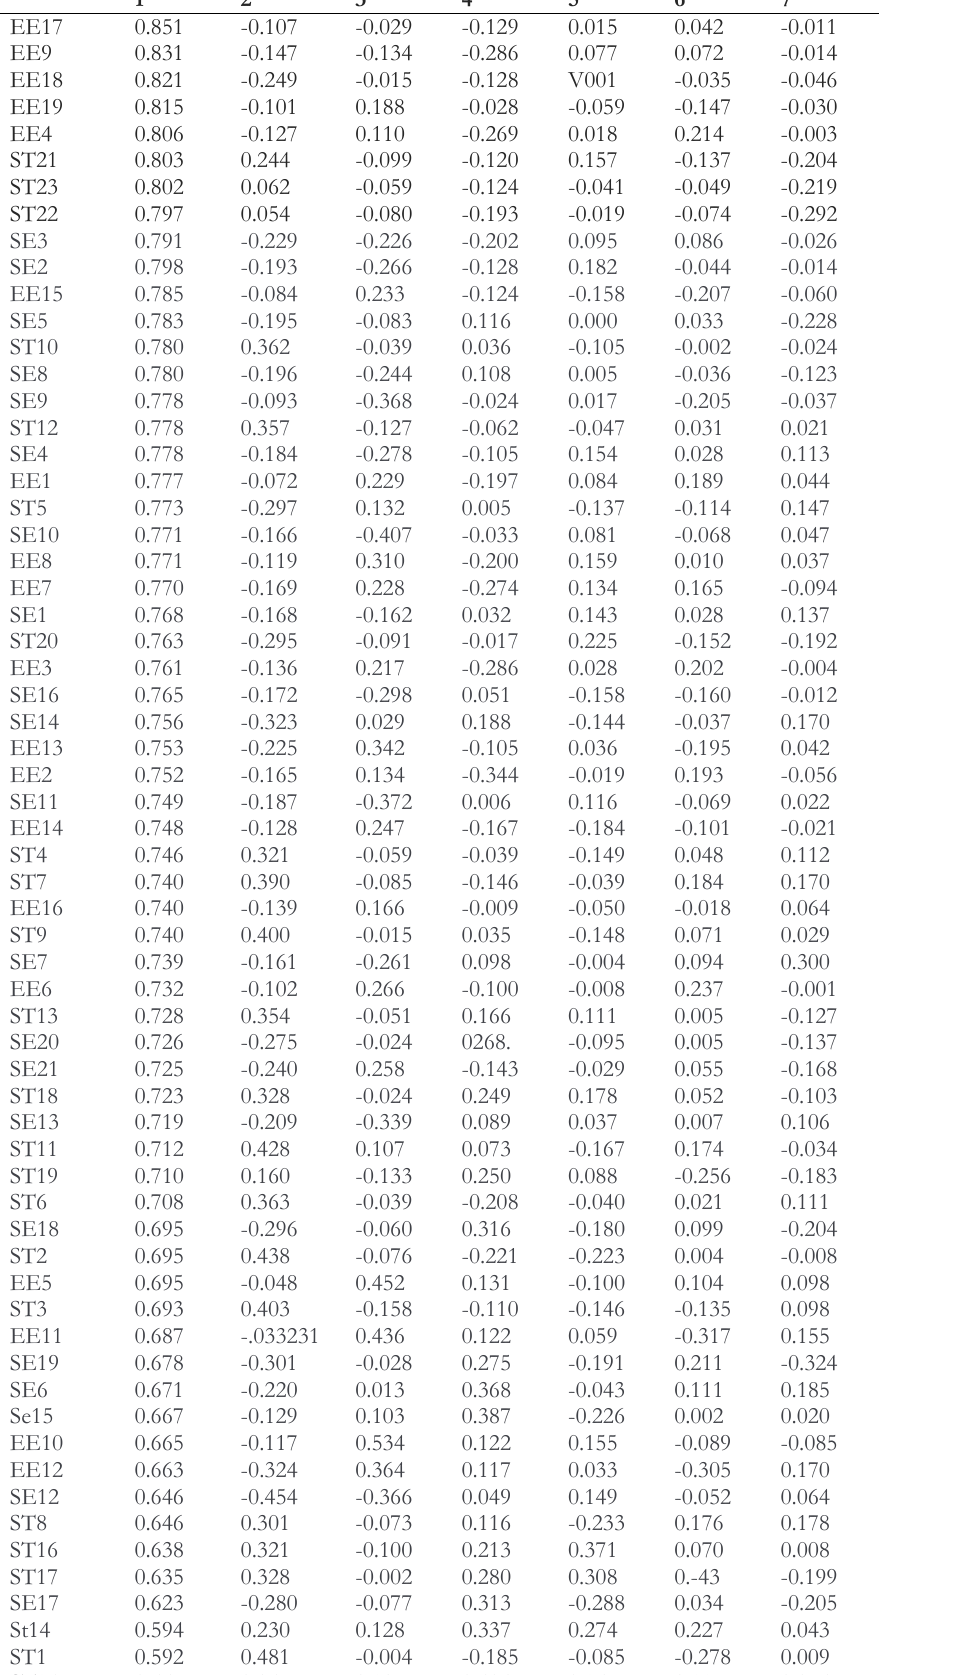
Table 6. Symbol of extracted factors and the contribution of each in determining the variance (source: software